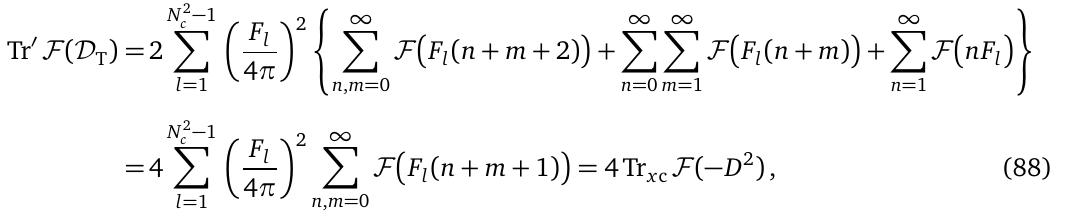
Figure 6: RG-consistency of the effective potential tegrating the initial effective potential eq. (89) at different initial cutoff-scales = 20,18,15 GeV to k = 0. The result is independent of the initial scale (RG- k UV